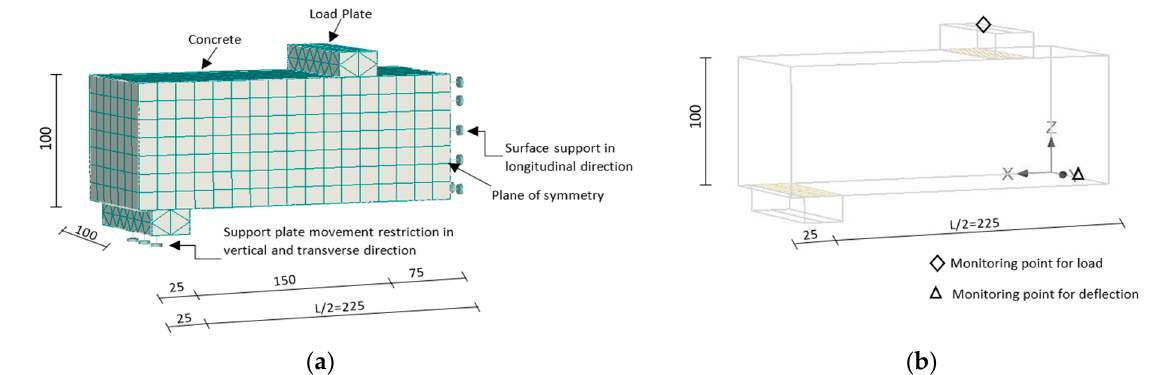
Figure 22. A typical FE model of a tested prismatic specimen: ( a ) geometry and boundary condition (dimensions are in mm); ( b ) monitoring points (dimensions are in mm). (dimensions are in mm); ( b ) monitoring points (dimensions are in